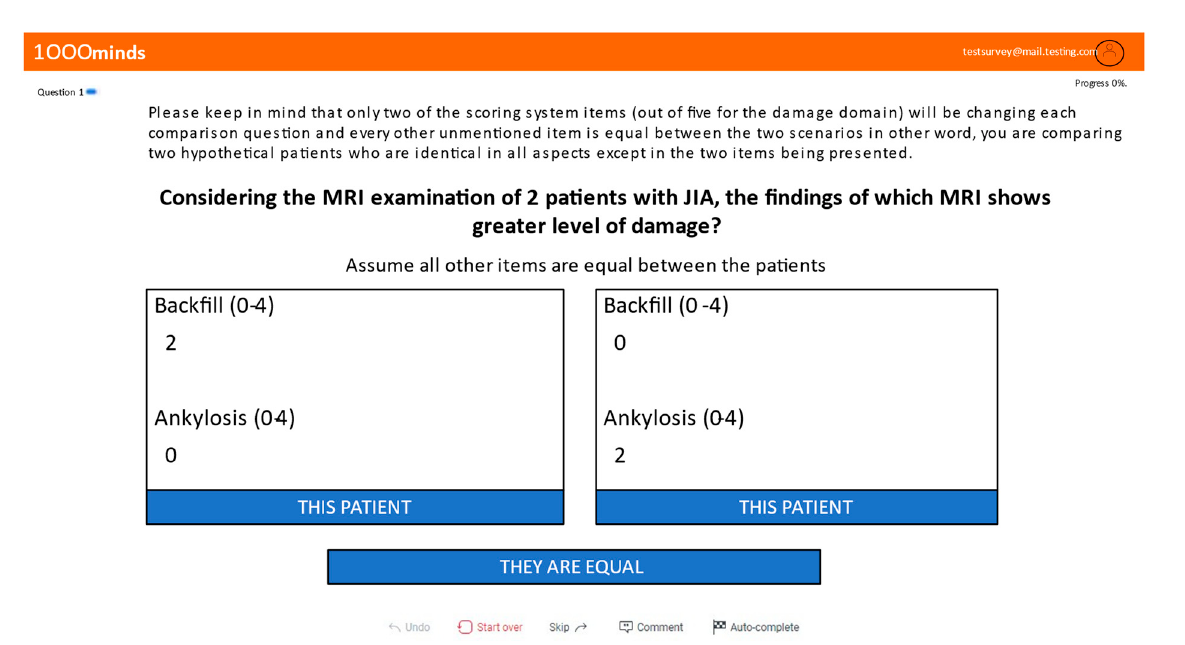
Figure A2. JAMRIS-SIJ damage domain item comparison. An example of an item comparison ques-